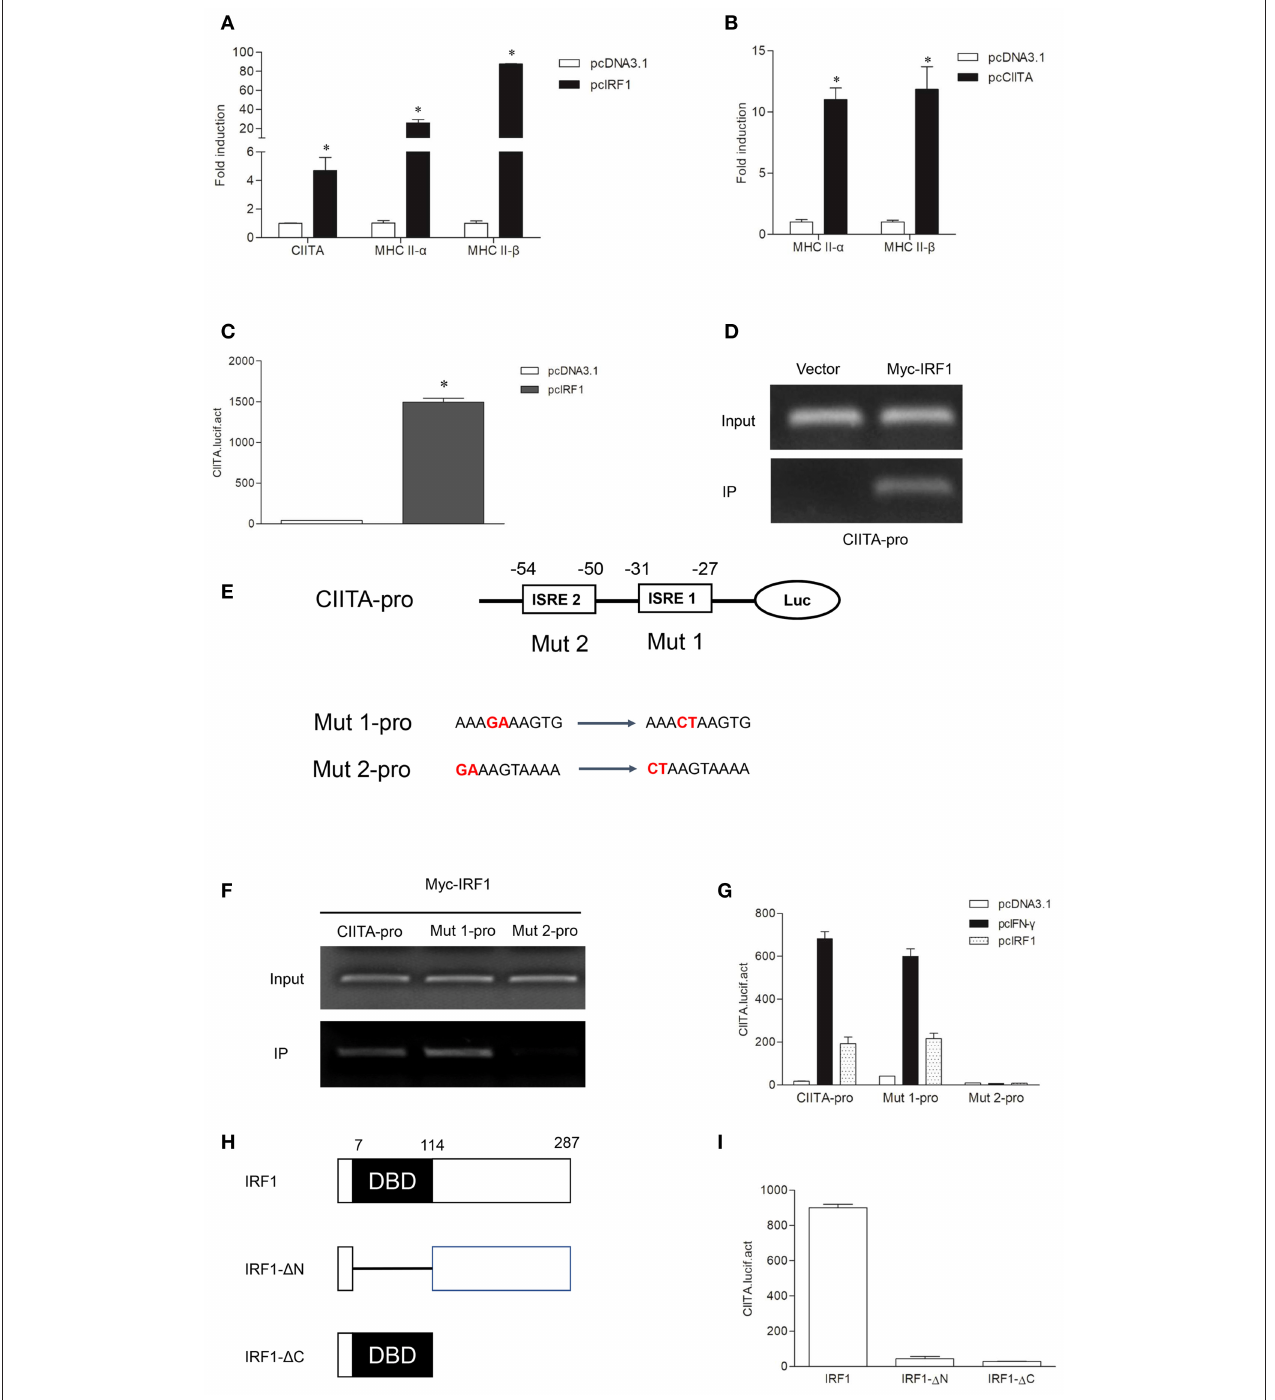
FIGURE 4 | Expression of the MHC II gene activated by IRF1 and CIITA. (A,B) IRF1 and CIITA induce MHC II expression. GCO cells were transfected with 1.0 µ g pcDNA3.1, pcIRF1, or pcCIITA respectively. Cells were harvested at 24h after transfection and fold changes of the gene expression were measured through qRT-PCR. (C) Activation of grass carp CIITA promoter by IRF1. GCO cells seeded in 24-well plate were cotransfected with (0.25 µ g pcDNA3.1 or pcIRF1) and CIITA promoter at the ratio of 1:1. pRL-TK was used as an internal control. Promoter activities were monitored at 24h after transfection. Asterisks (*) indicate significant differences from control ( p < 0.05). (D) The binding of IRF1 with CIITA promoter. 293T cells seeded in 10-cm dishes were cotransfected with 5 µ g Myc-IRF1 and 5 µ g CIITA-pro. Empty vector PCMV-Myc (5 µ g) was transfected in parallel as control. After 24h, cell lysates were immunoprecipitated with anti-Myc-Agarose beads.